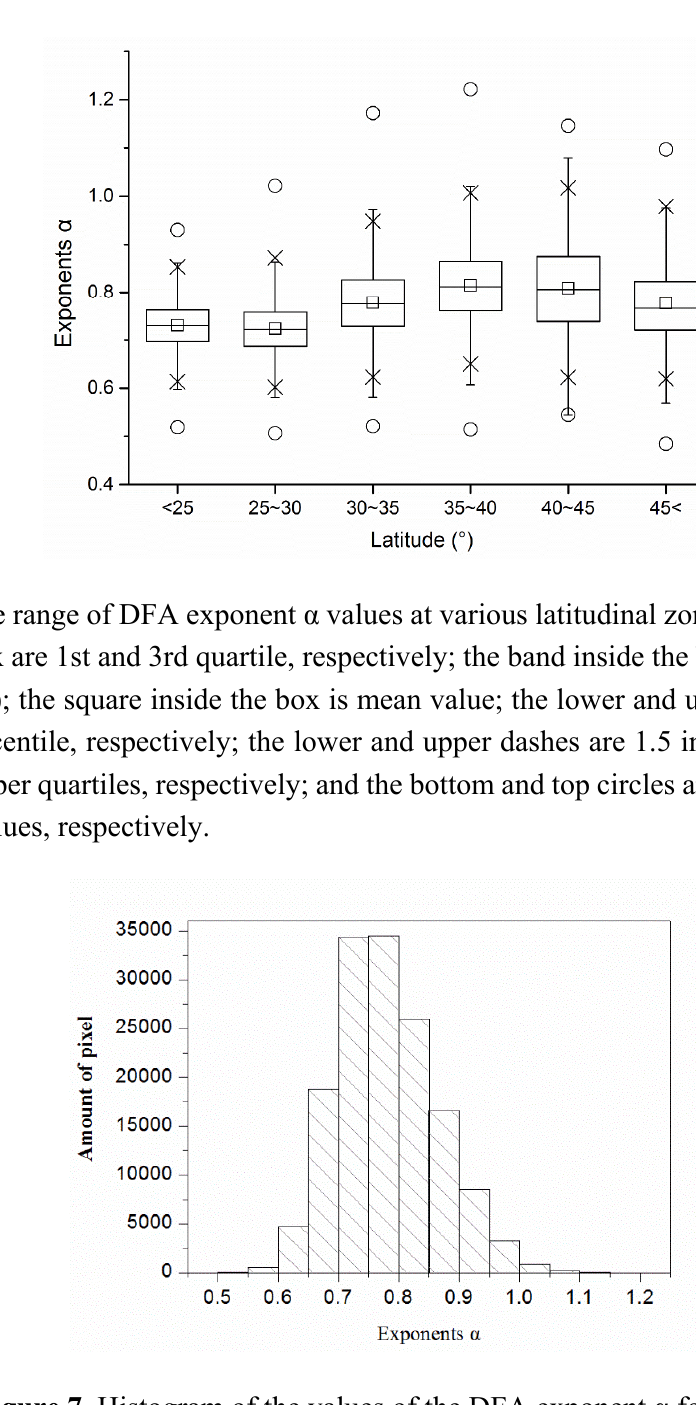
Figure 7. Histogram of the values of the DFA exponent α for